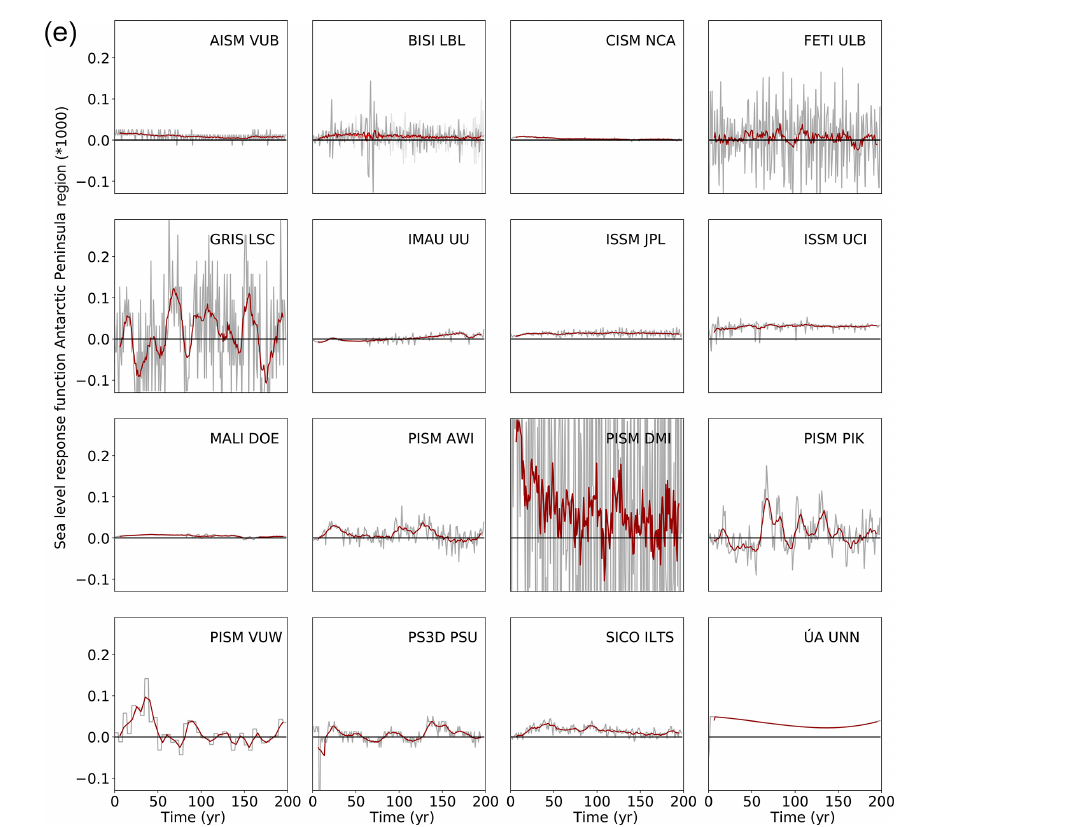
Figure 5. (a) Response function for the East Antarctica region. Response function computed from the time derivative of the response of the ice sheet models within the experiment with additional basal melting of 8myr − 1 divided by 8myr − 1 . The response function is thus unitless in this specific case. The red line provides a 10-year running mean. For the BISI LBL model the simulation with 1km horizontal resolution (compared to the main simulation with 500m horizontal resolution that is used for the projections) is also shown. These are the light grey lines and the light red 10-year running mean. (b) Response function for the Weddell Sea region as in panel (a) . (c) Response function for the Amundsen Sea region as in panel (a) . (d) Response function for the Ross Sea region as in panel (a) . (e) Response function for the Antarctic Peninsula region as in panel (a)